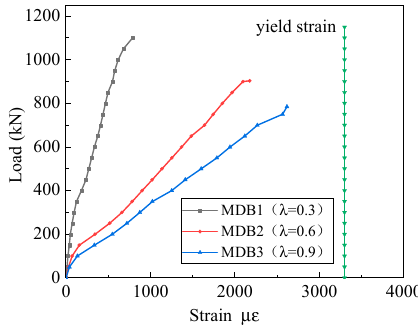
Figure 9. Relation curve between λ and longitudinal reinforcement strain.